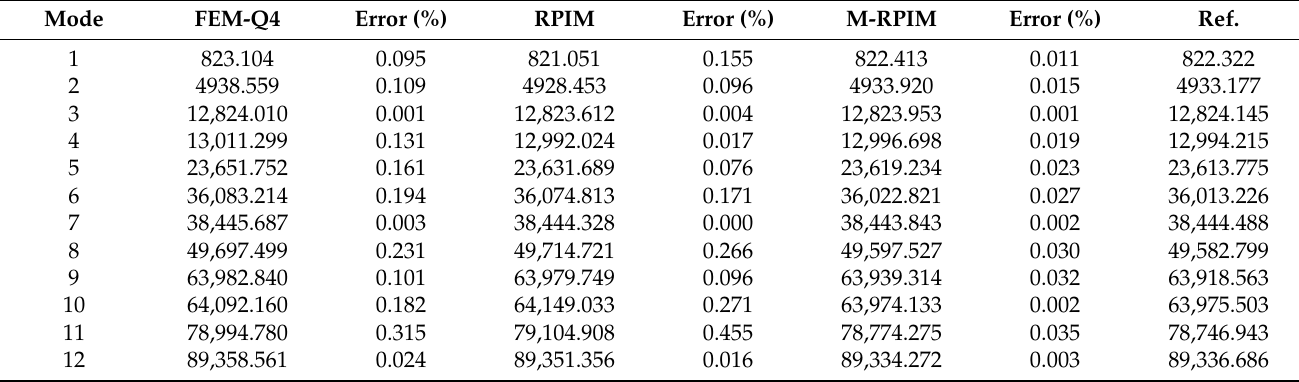
Table 3. The first twelve natural frequency solutions from the three numerical methods using the node arrangement pattern with average nodal space h = 0.67